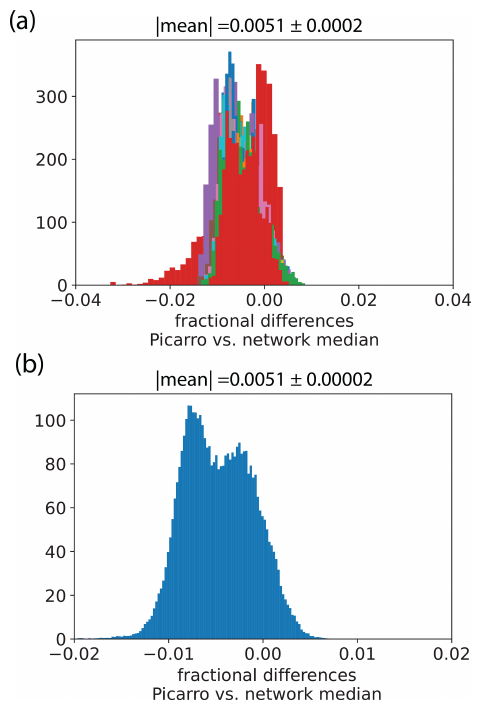
Figure 11. (a) Histogram of the fractional differences between sites with temperature-corrected CO 2 calculated using the Picarro instru- ment and the Bay Area network median as a reference. Different colors represent different sites. The mean indicated is the average of the absolute values of each neighboring pair’s mean fractional difference. (b) Histogram of the aggregated fractional differences between sites with temperature-corrected CO 2 calculated using the Picarro instrument and the Bay Area network median as a reference. The mean and error indicated are the mean and 95% confidence in- terval of the distribution.